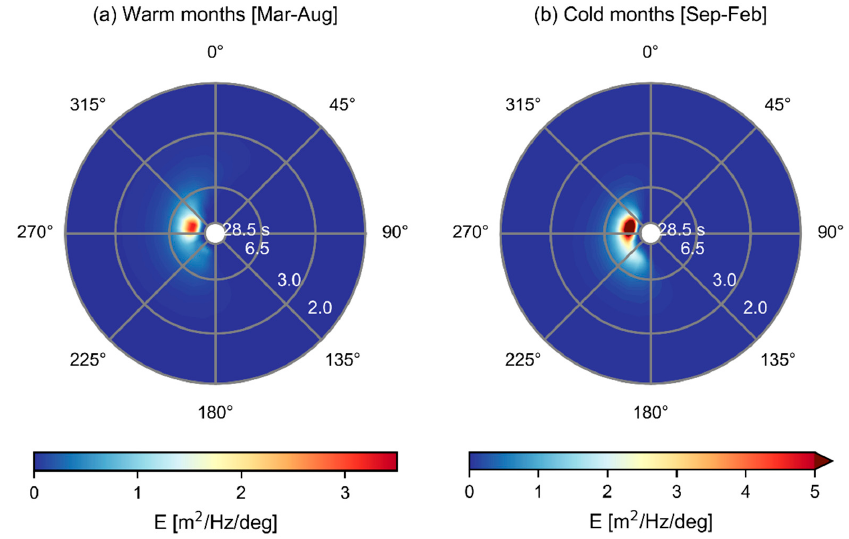
Figure 2. PWS spectra during ( a ) warm (March through August) and ( b ) cold (September through February) months averaged from January 1979 to December 2010.